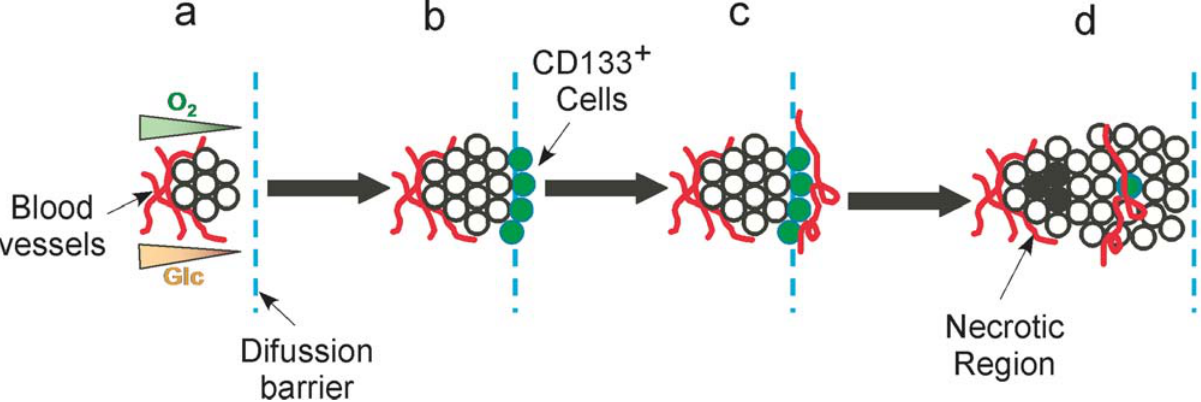
Figure 7. Tumor progression model: (a) Initiation of tumor formation. (b) Tumor growth restricted at the oxygen and glucose diffusion barrier. (c) Glioma ells at the edge of the tumor will be re-oxygenated by neovascularization, and grow and divide until they reach a new oxygen and nutrient diffusion barrier. (d): repetitive cycles of growth and angiogenesis occur during the progression of the tumor.